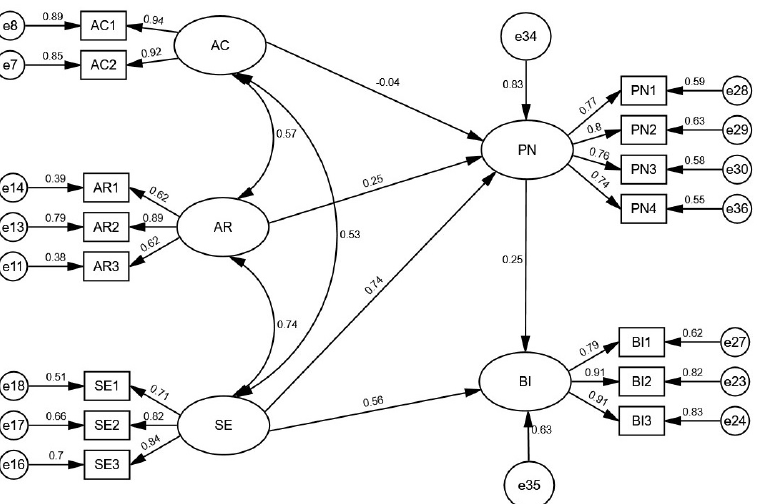
Figure 3. Structural equation model and standardized path coefficient graph. Note 1: AC, awareness of consequence of food waste; AR, ascription of responsibility for food waste; PN, personal norm to reduce food waste; SE, self-efficacy; BI, behavior intentions to reduce food waste. Note 2: The ellipse on the inside represents latent variables; the rectangle represents items of variables; the circle on the outside represents the residual; the number on the line represents the standardized path coefficient; and the number next to the figure represents the explained variances.